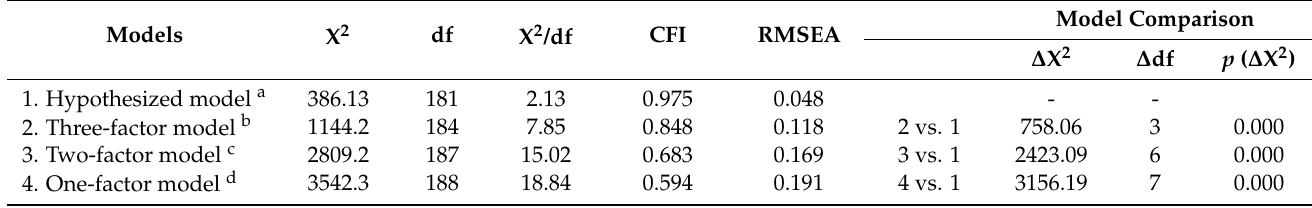
Table 3. Goodness-of-fit values regarding the models.